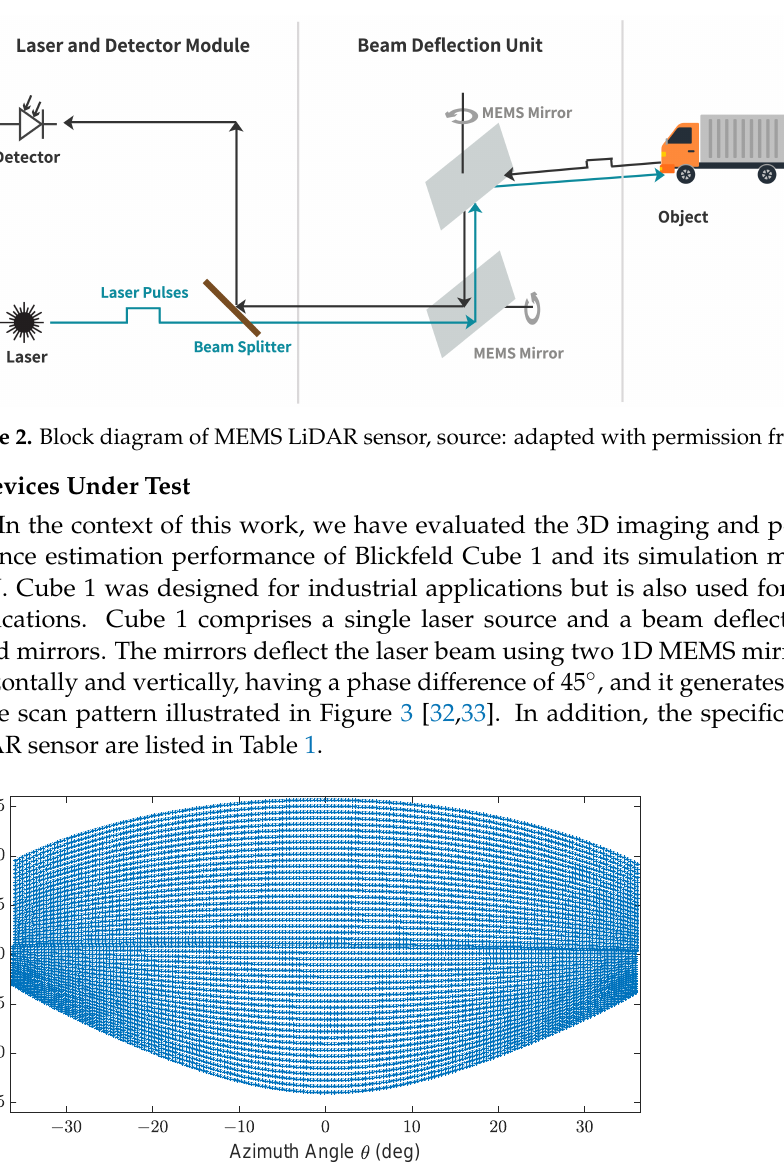
Figure 3. Exemplary elliptical shape scan pattern of Cube 1. Specifications: ± 36 ◦ horizontal and ± 15 ◦ vertical FoV, 50 scan lines, 0.4 ◦ horizontal angle spacing, frame rate 5.4Hz, the maximum detection range is 250m, and the minimum detection range is 1.5m. Table 1. Parameter specification of Cube 1 LiDAR sensor